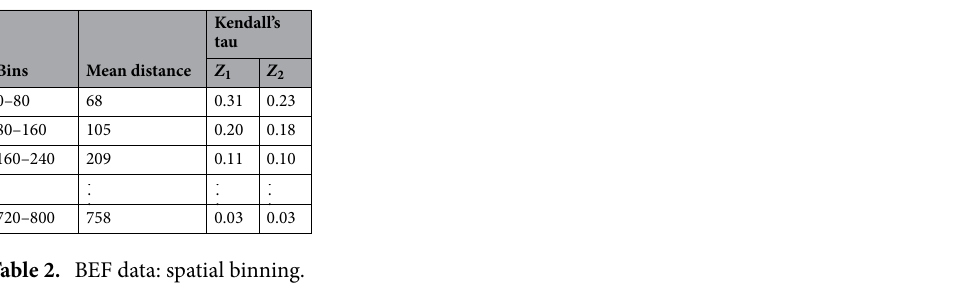
Table 2. BEF data: spatial